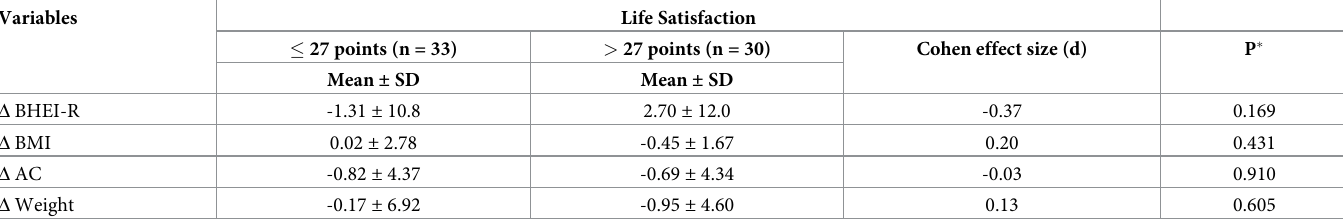
Table 6. Classification of life satisfaction (dichotomized at the median) associated with the BHEI-R, BMI, AC and weight of patients with metabolic syndrome, Porto Alegre, Brazil (n = 63).